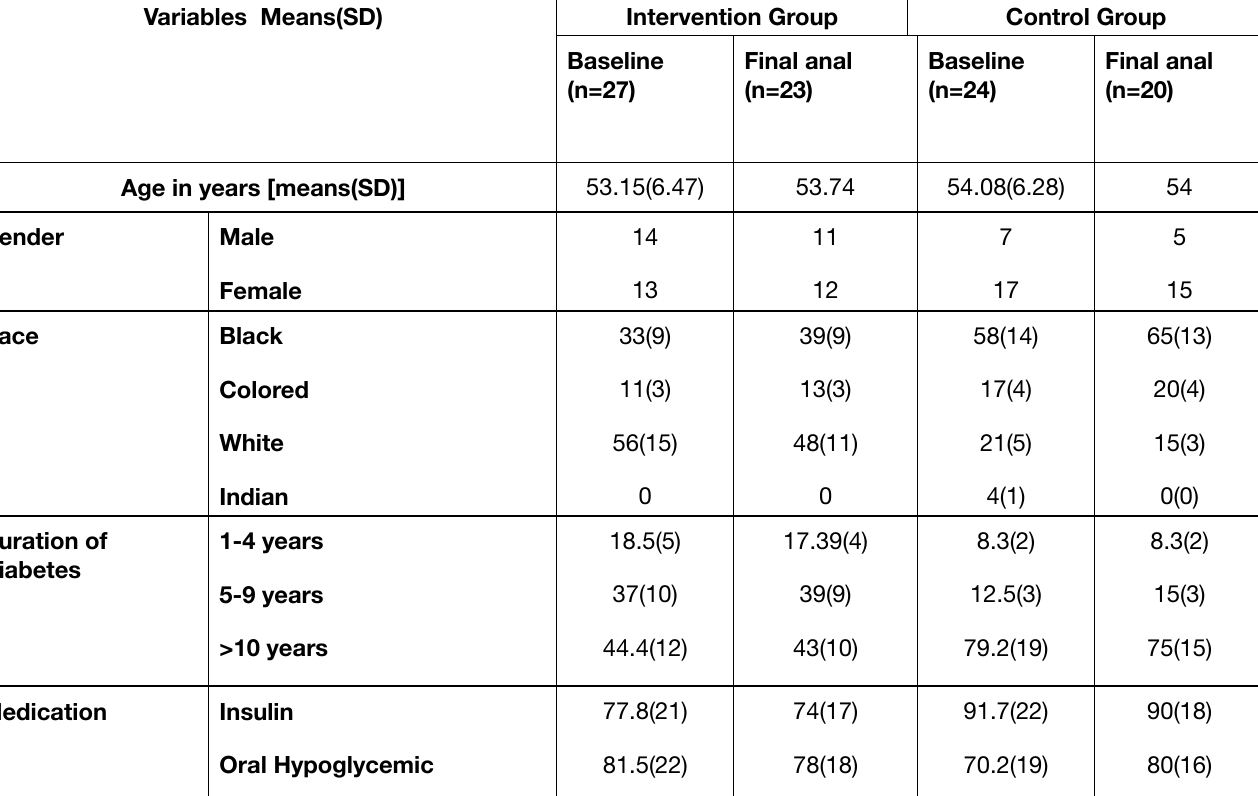
Table 1: The baseline biographic characteristics of all participants in the trial, those lost to follow-up, and those remaining in the trial to the end. Values are percentages (numbers) unless stated otherwise.